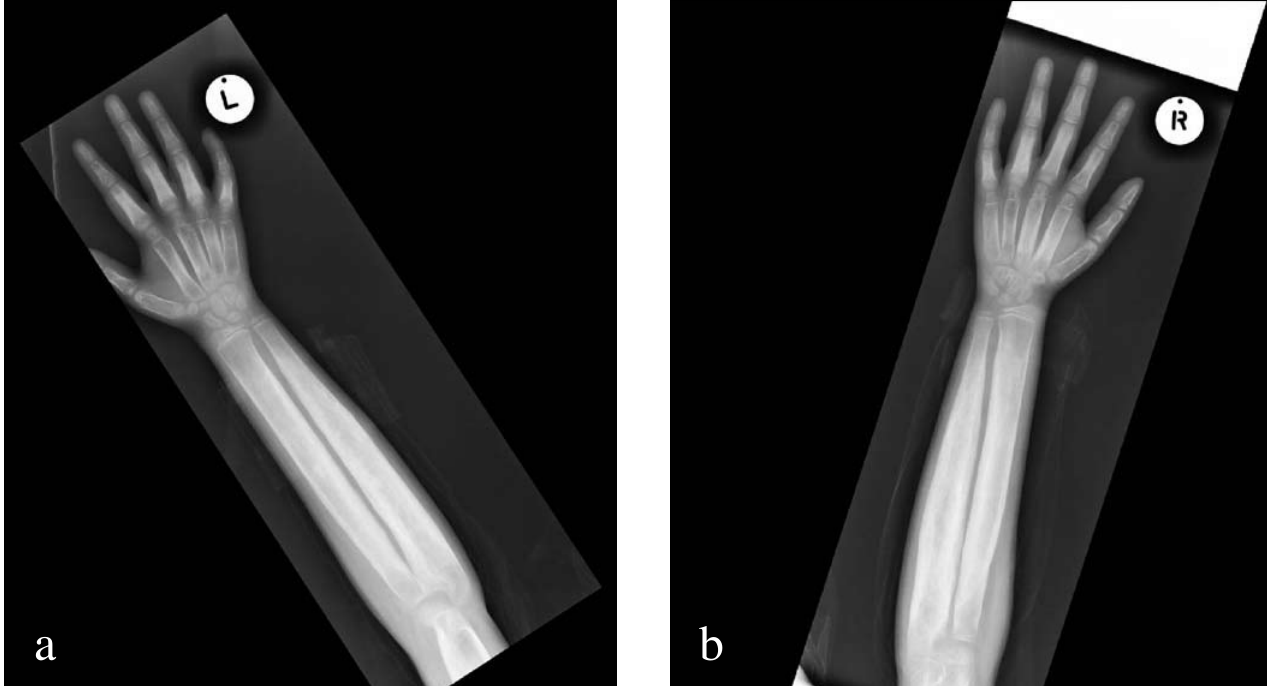
Figs 3a and b. The marked cortical thickening results in narrowing of the medullary cavity.